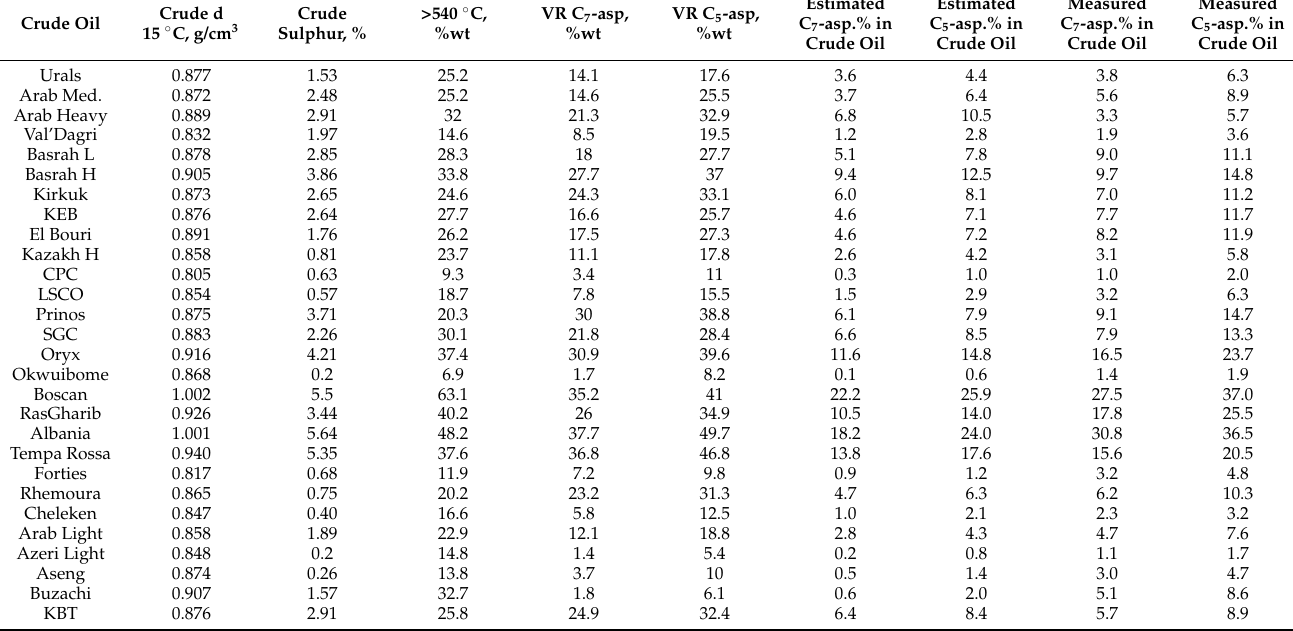
Table 2. Content of C 5 -, and C 7 -asphaltenes in crude oils and their vacuum residue fractions. Crude Oil Crude d 15 ◦ C, g/cm 3 Crude Sulphur,